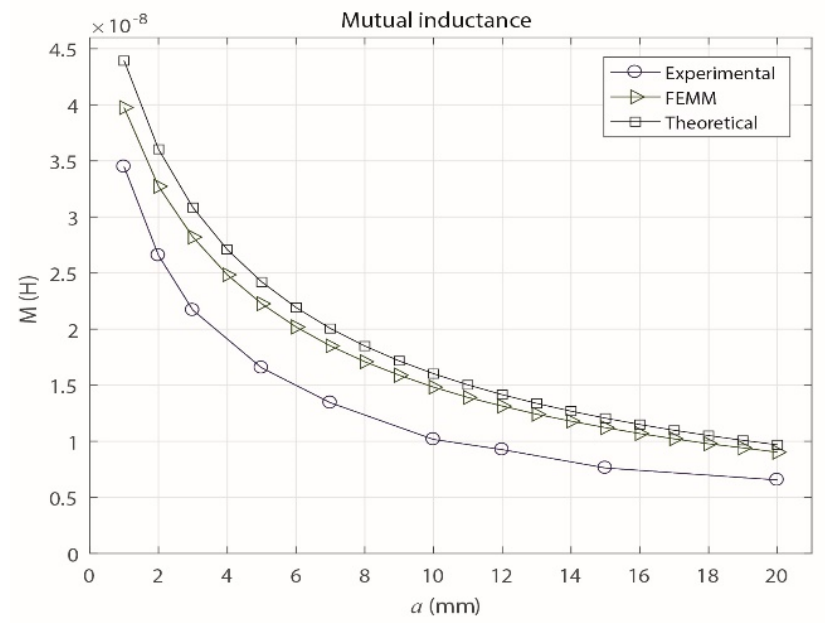
Figure 9. Comparison of the mutual inductances obtained with the three analysis methods.